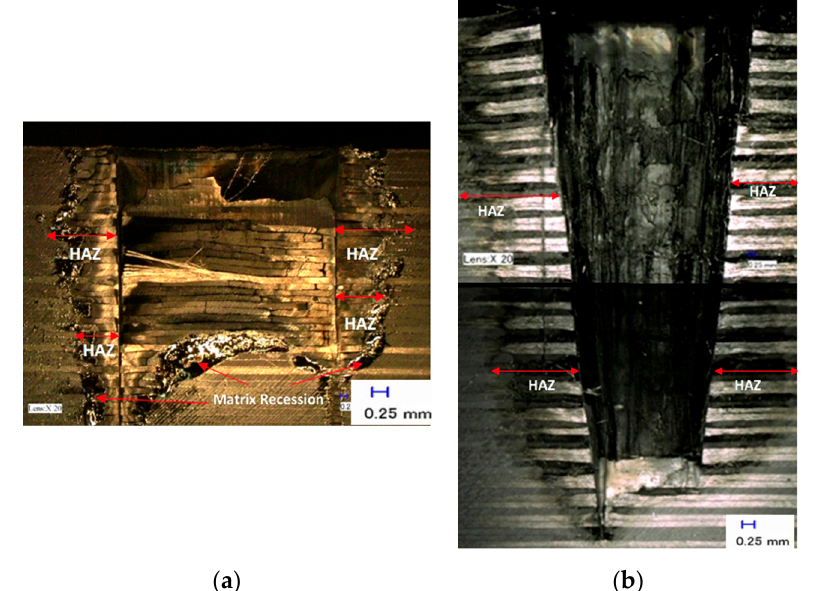
Figure 11. The results of two drilling strategies: ( a ) single ring shape with 10 multiple passes, and ( b ) spiral trepanning with single pass.